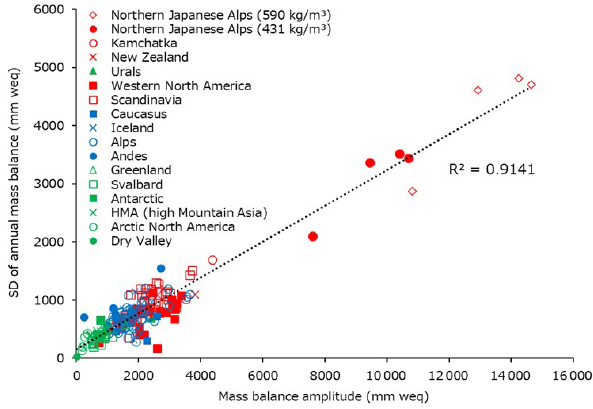
Figure 12. Standard deviation of annual mass balance versus mass balance